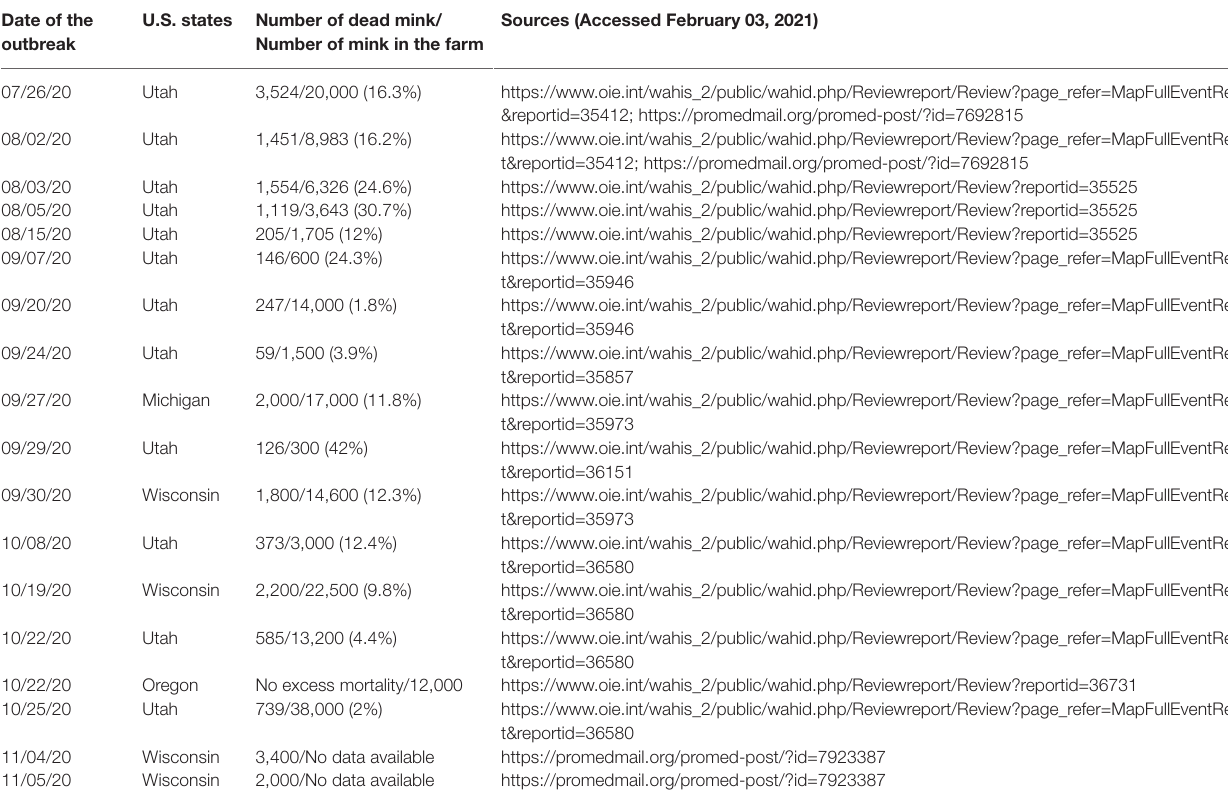
TABLE 3 | Mortality rates of mink infected by SARS-CoV-2 according to the farms in the United States of